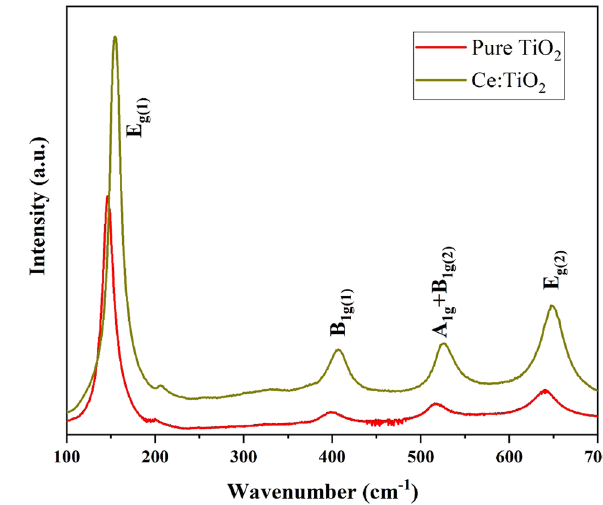
Figure 2: Raman analysis of pure and Ce - doped TiO 2